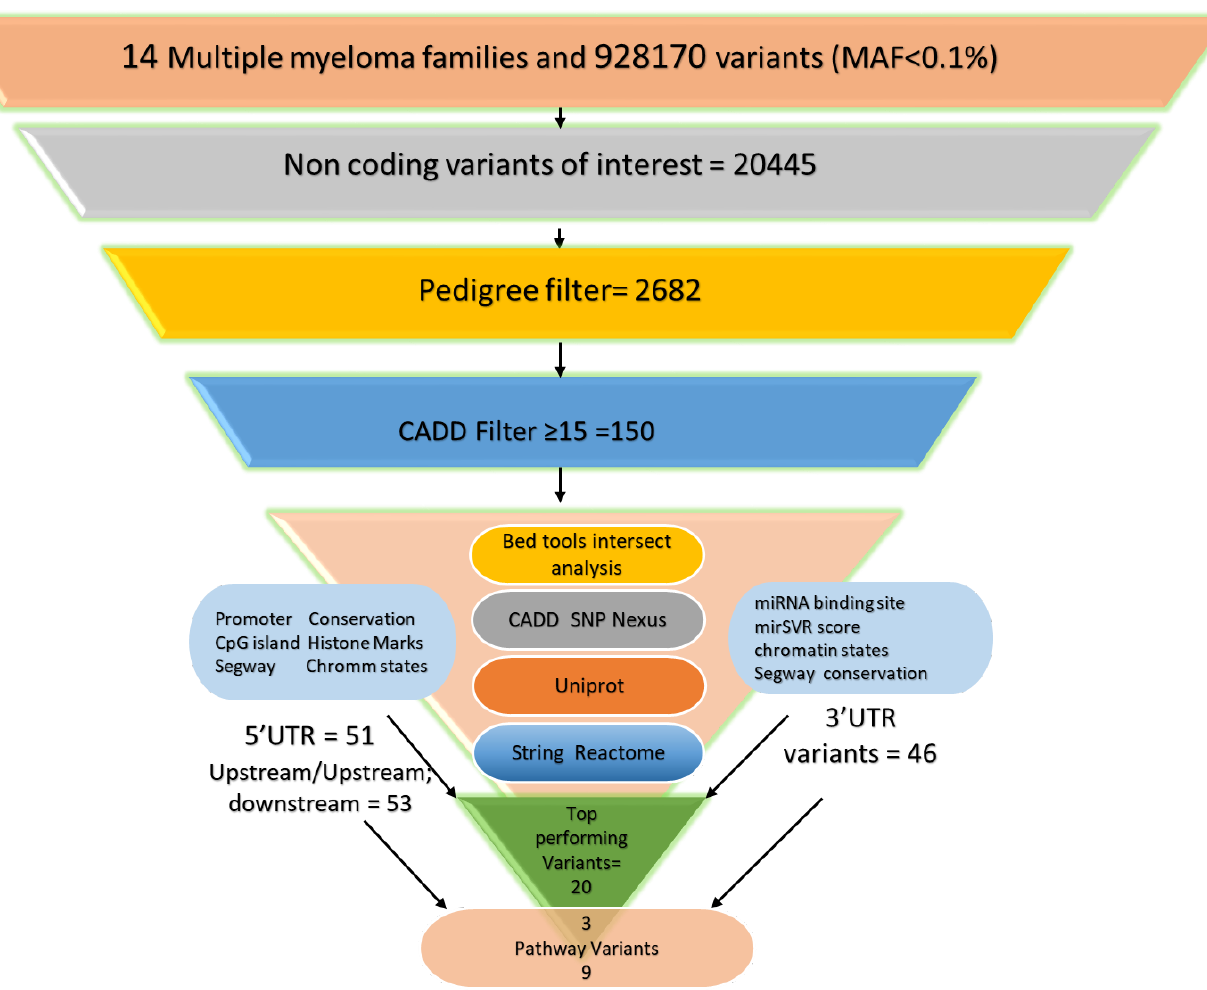
Figure 1. Prioritization pipeline with the number of filtered variants at each step, including the number of top variants among 5′ UTR, upstream and 3′ UTR variants, and variants identified by the protein interaction and pathway enrichment analyses .